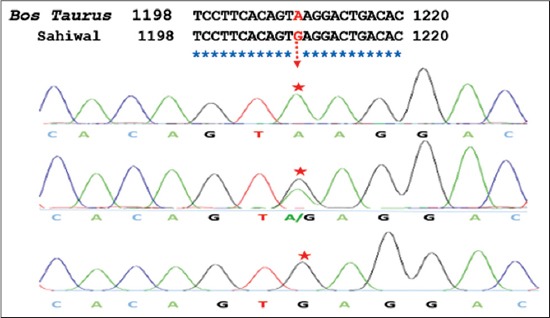
Chromatograph showing SNP at position 1209 A>G of HSP90AA1 gene in Sahiwal cow